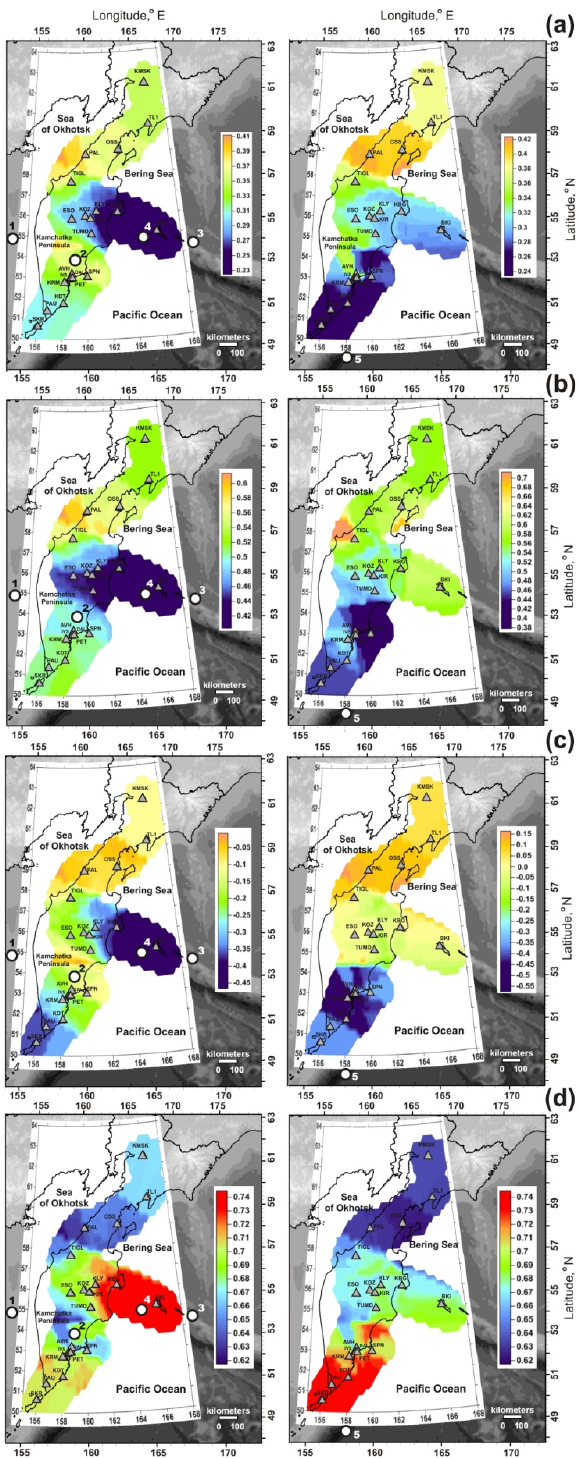
Figure 4. Maps of seismic noise parameters’ distribution for 2011–2018 (left) and for 2019–2021 (right). ( a ) Generalized Hurst exponent α *; ( b ) singularity spectrum support width ∆ α ; ( c ) wavelet-based spectral exponent β ; and ( d ) normalized entropy of the squared orthogonal wavelet coefficients En . The white circles show the earthquake epicenters (Table 3) that occurred over the corresponding time periods. Rectangles with a coordinate grid show the area of noise parameters’ calculation. The coloring corresponding to the color scales was carried out for the area at a distance of no more than 120 km from the edge stations of the network (Figure